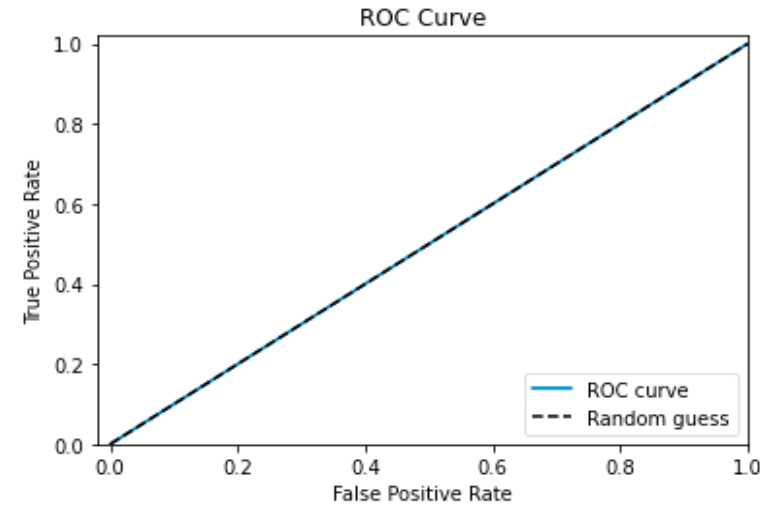
Figure 12. ROC curve of the proposed model for test data.